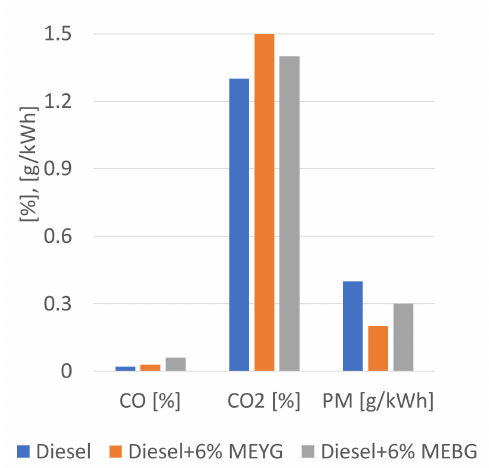
Figure 6. The engine emissions of CO, CO 2 , and PM obtained at zero load of engine supplied with pure diesel, diesel with 6% of rapeseed oil methyl ester, and diesel with 6% of goose fat methyl ester,